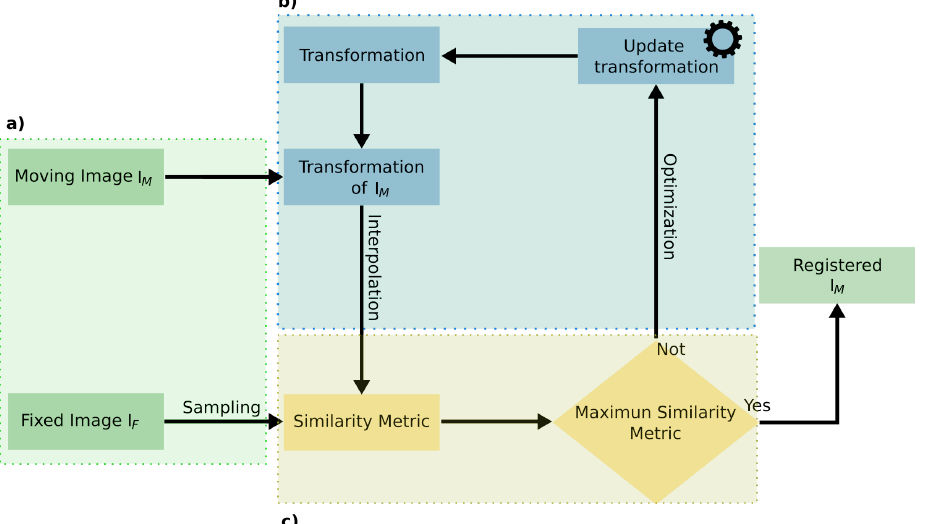
Figure 3. Registration procedure. ( a ) Input images for the registration. ( b ) Optimization of the transformation for I M . ( c ) Measurement of the similarity metric to compare the transformed I M with I F